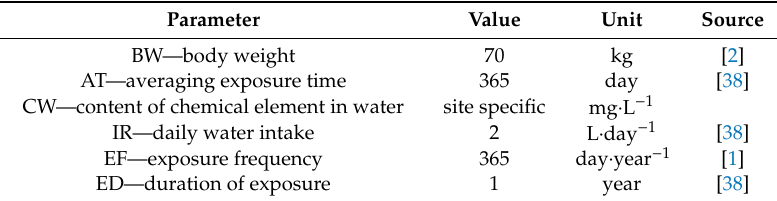
Table 3. Input exposure data for the estimation of health risk from deficient Ca and Mg contents in drinking water for adult